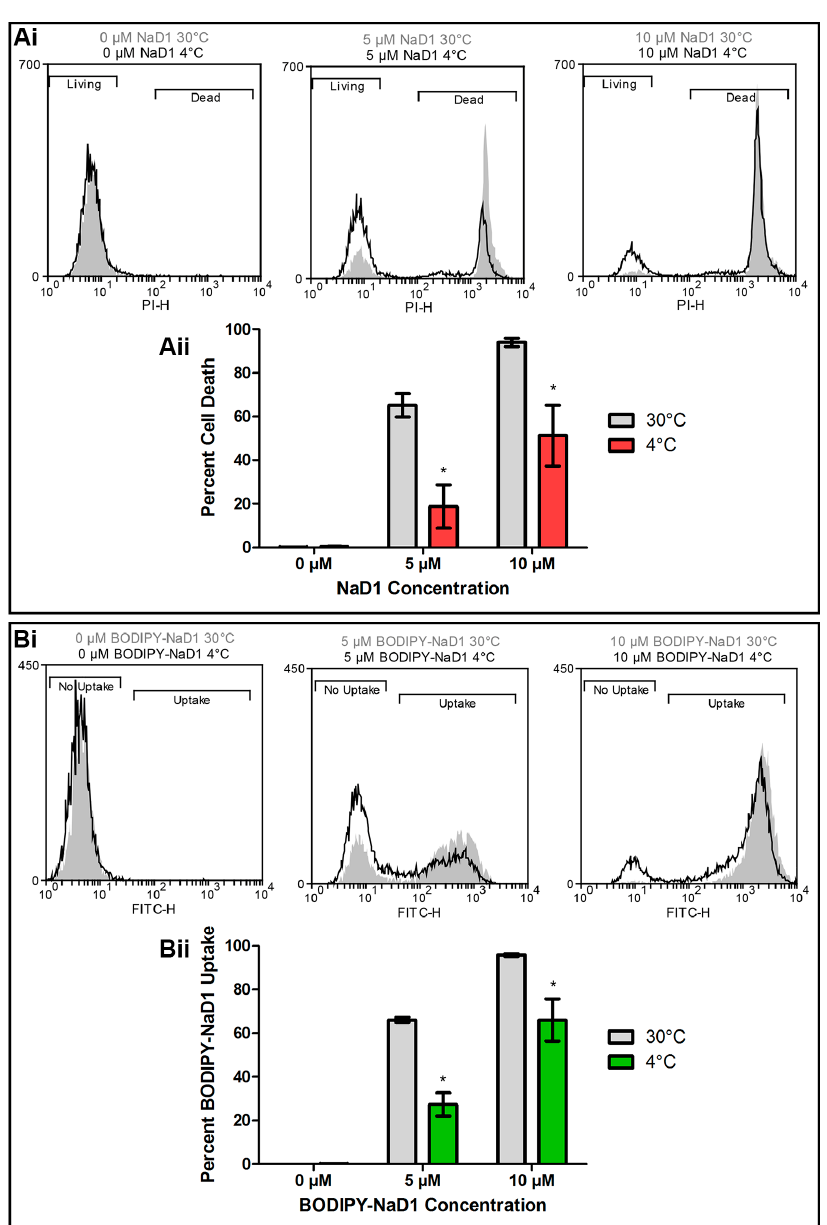
Figure 2. NaD1 induced cell death and uptake is reduced at 4 °C. ( Ai ) C. albicans DAY185 was treated with 0, 5 or 10 µM NaD1 for 30 min at 30° and 4 °C. PI (5 µM) was added for quantitation of cell death. Cells with PI fluorescence were counted using a flow cytometer to separate living and dead cells at both 30 °C (grey shading) and 4 °C (black line). Data is a representative example from three independent experiments; ( Aii ) The percentage of PI positive cells (percent cell death) relative to total cell counts was also calculated for three biological replicates and is shown in a bar graph. Error bars are standard error of the means. Values marked by an asterisk are significant (using an independent t -test) compared to the 30 °C control ( p -value < 0.05); ( Bi ) C. albicans DAY185 was treated with 0, 5 or 10 µM BODIPY-NaD1 for 30 min at 30° and 4 °C. Cells with BODIPY fluorescence were counted using a flow cytometer and separated to determine the relative numbers of cells that had or had not taken up BODIPY-NaD1 at 30 °C (grey shading) or 4 °C (black line). Data is a representative example from three independent experiments; ( Bii ) The percentage of BODIPY-NaD1 positive cells relative to total cells counts was also calculated for three biological replicates and is shown in a bar graph. Error bars are standard error of the mean. Values marked by an asterisk are significant (using an independent t -test) compared to the 30 °C control ( p -value < 0.05).